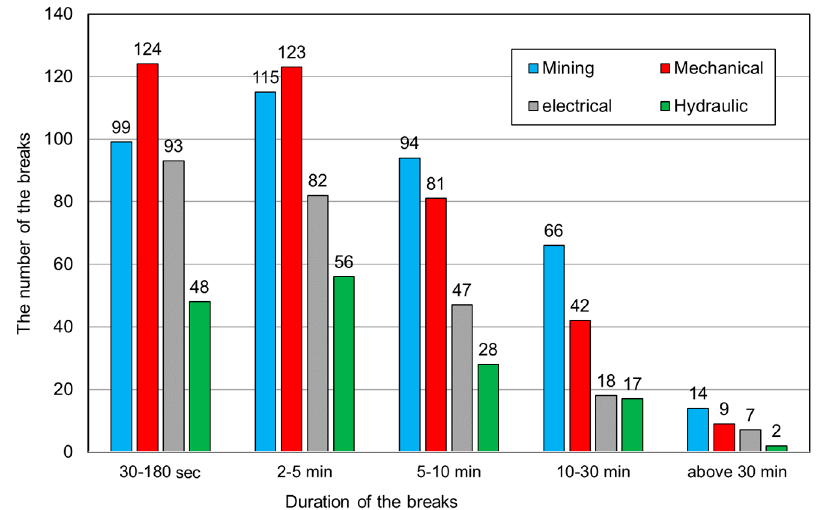
Figure 11. Types of causes of breaks in the shearer loader’s work for particular time categories.